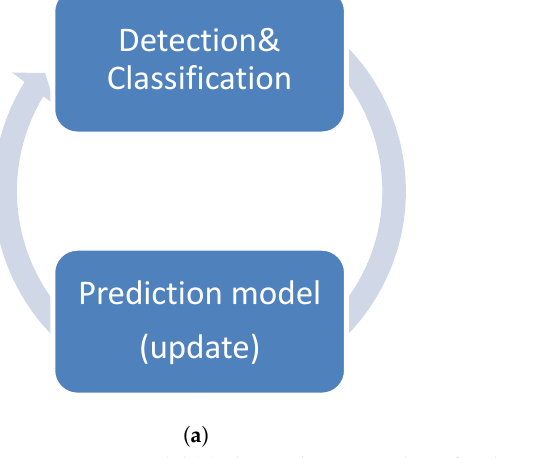
Figure 4. Model ( a ) shows the system loop for the initialization process. To guarantee the tracking and counting components to work properly the prediction model must be set up first. Model ( b ) shows the system loop for the actual counting framework consisting of four main components. Each processing unit delivers its data to the next